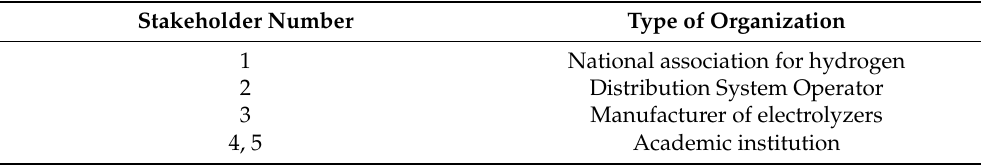
Table 1. Stakeholders involved in the call for evidence.